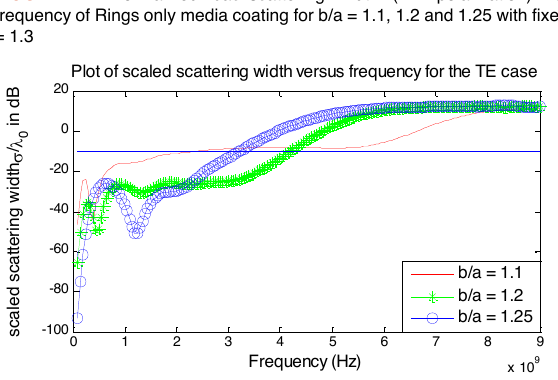
FIGURE 8. Normalized backscattering width (TE polarization) versus frequency of Rings only media coating for b/a = 1.1, 1.2 and 1.25 with fixed c/a = 1.3